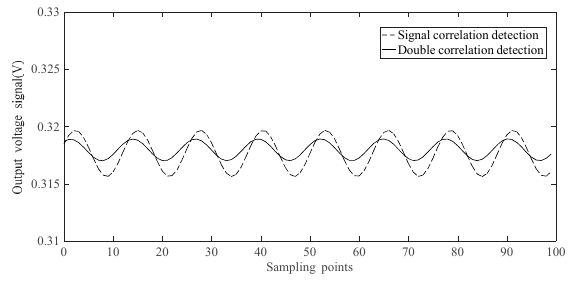
Figure 6. Output of one optical path.